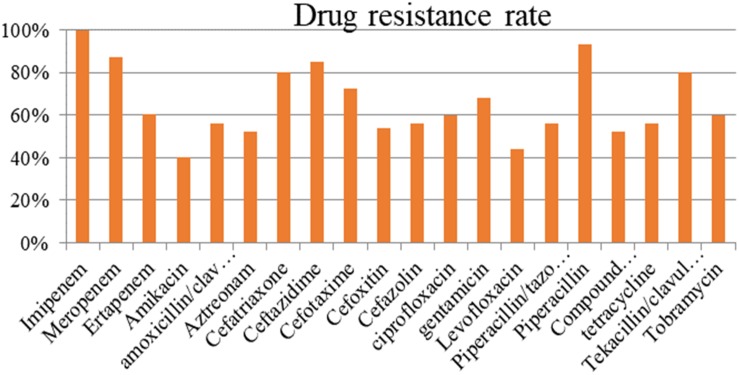
Drug resistance in blaNDM–1-positive strains.